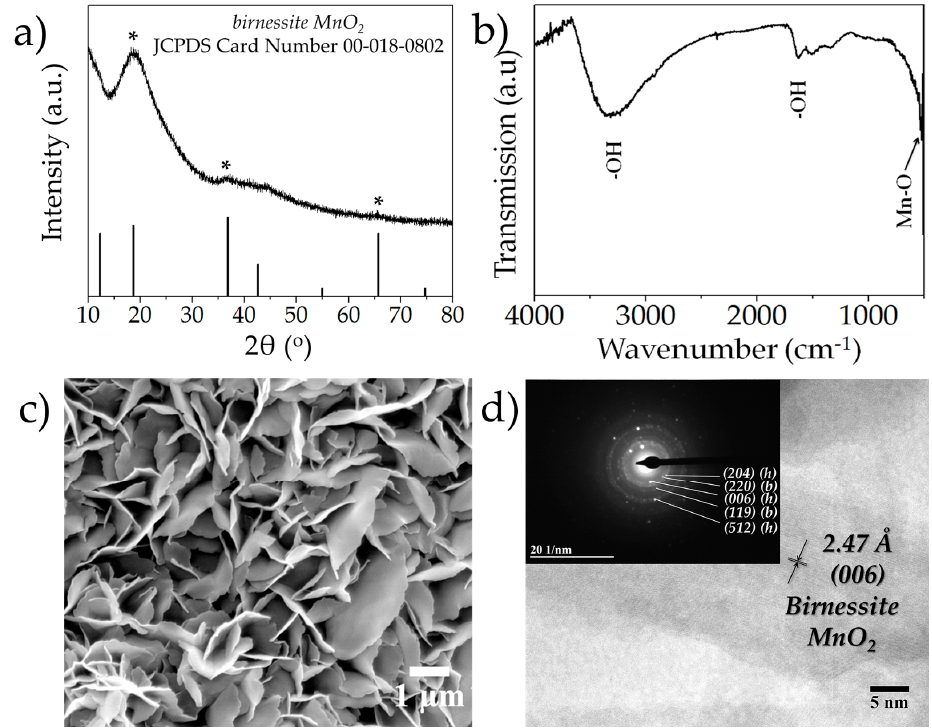
Figure 2. ( a ) XRD pattern of the cycled MnO x powders; ( b ) FTIR pattern of the cycled MnO x films; ( c ) microstructure of the cycled MnO x films showing layered platelet-like morphology; ( d ) HRTEM of the cycled MnO x powders; the inset shows the SAED pattern, ( b ) represents birnessite phases, whereas ( d ) represents hausmannite phase.